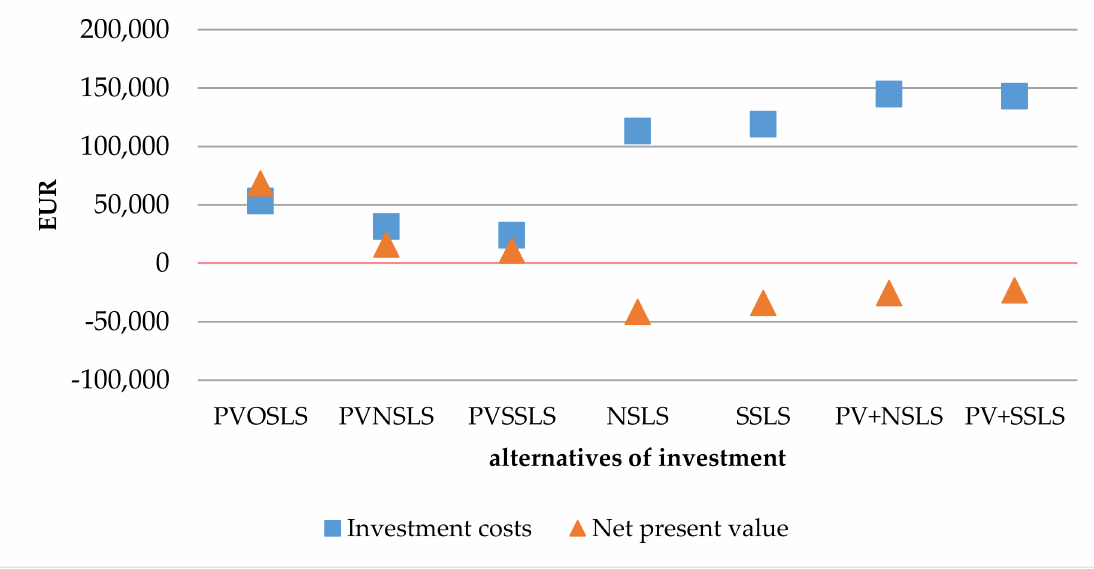
Figure 2. Comparison of the different investments